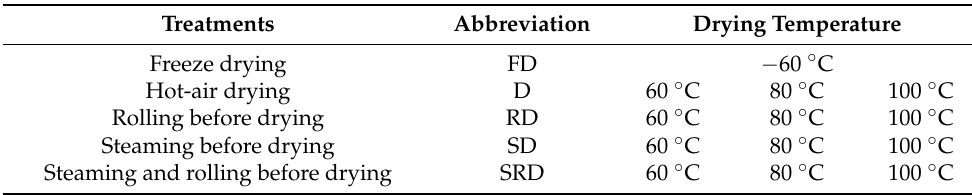
Table 1. Manufacturing processes used for Dendrobium catenatum leaves.